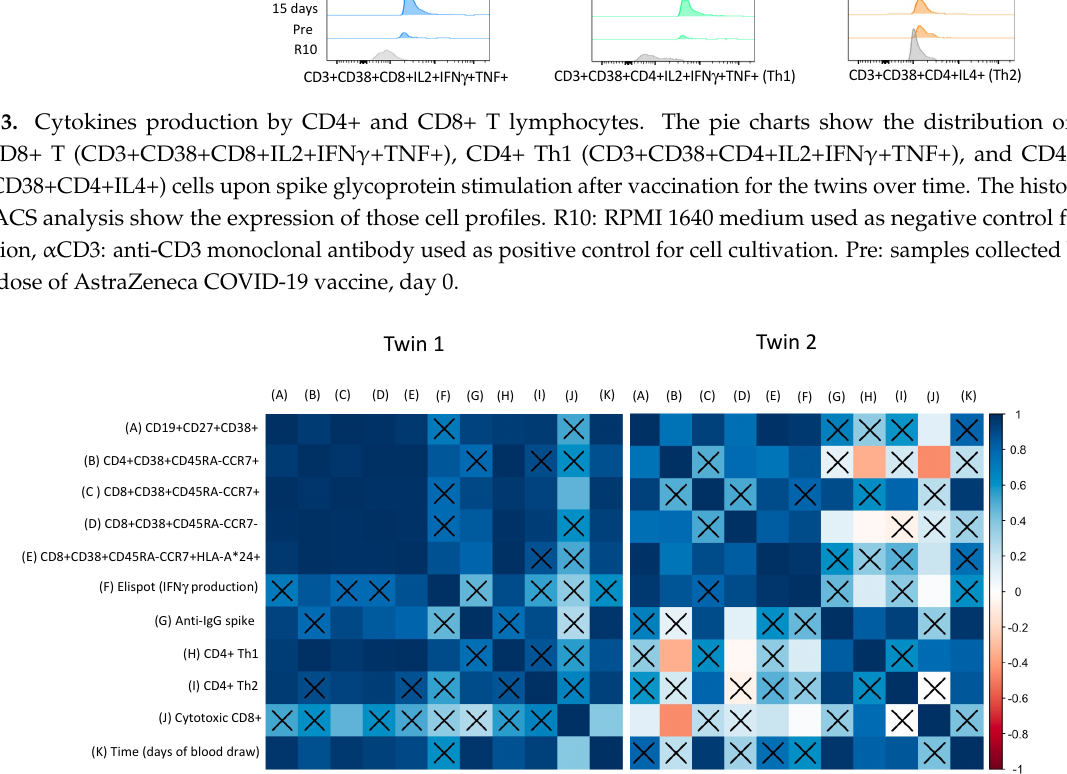
Figure 4. Correlation between humoral and cellular response upon COVID-19 vaccination. The correlation was calculated with individual data from the twins. ( A ) activated memory B cells, ( B ) central memory CD4+ T cells, ( C ) central memory CD8+ T cells, ( D ) effector memory CD8+ T cells, ( E ) central memory CD8+ T cells expressing HLA type, ( F ) IFN γ -secreted cells (Elispot assay), ( G ) anti-IgG spike (serological assay), ( H ) activated CD4+ Th1 cells (CD4+IL2+IFN γ +TNF+), ( I ) activated CD4+ Th2 cells (CD4+IL4+), ( J ) activated cytotoxic CD8+ T cells (CD8+IL2+ IFN γ +TNF+), ( K ) time points of blood collection. Insignificant p values ( p > 0.05) are highlighted with X.